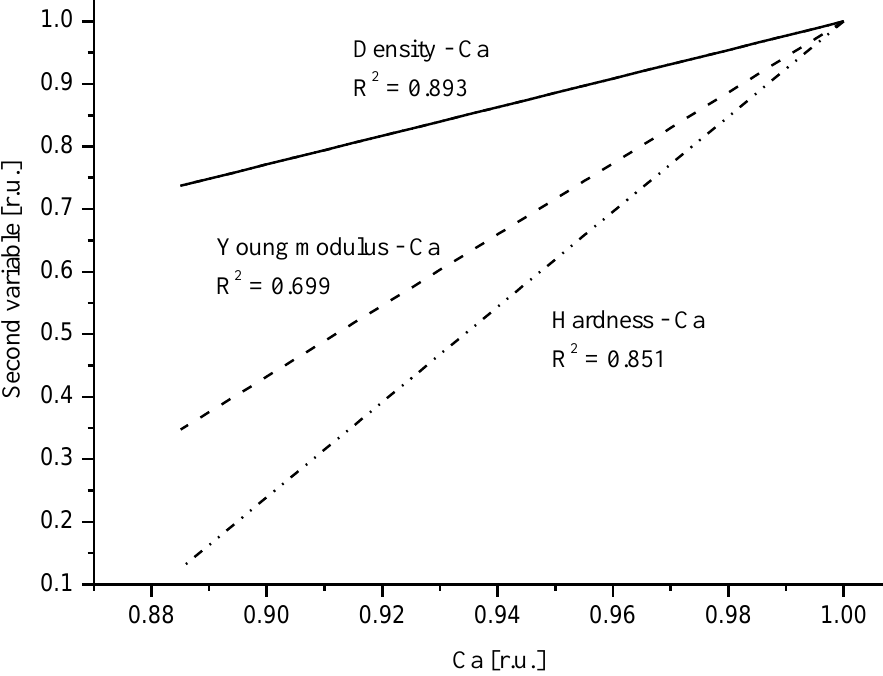
Figure 5. Comparison of the linear fits to the correlation relationships between relative values of density and Ca (solid line); Young modulus and Ca (dotted line); hardness and Ca (dot-drop line). Relevant equations are: RDen = −1.27 + 2.287 × [RCa]; RYM = −4.68 + 5.678 × [RCa]; RH = −6.61 + 7.609 × [RCa].